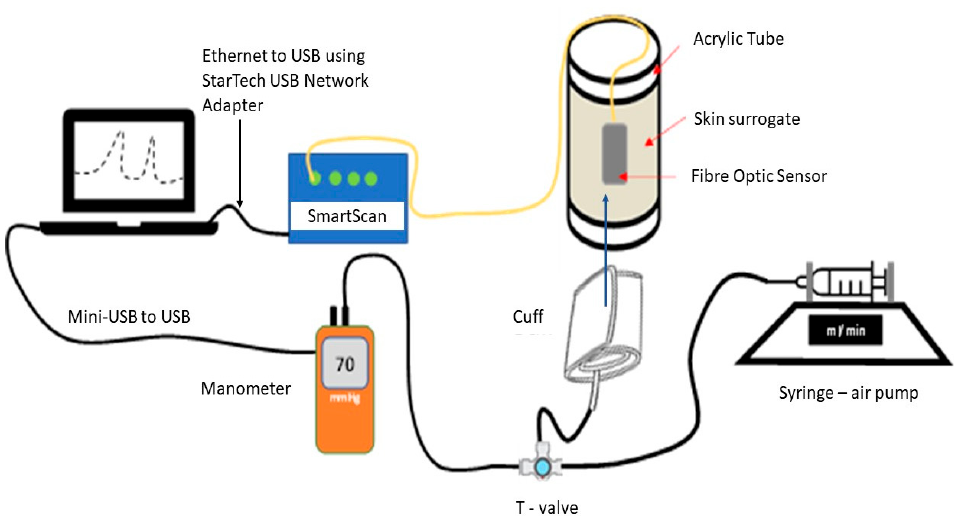
Figure 4. Experimental setup for measurements using a blood pressure cuff. A controlled volume of air is added via syringe pump to the cuff, which is wrapped around the materials on the acrylic tube. The pressure of the cuff is recorded by the manometer and is compared to the wavelength shift recorded by the interrogator.